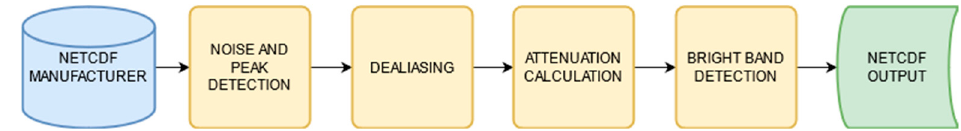
Figure 2. Flowchart of the new processing methodology.